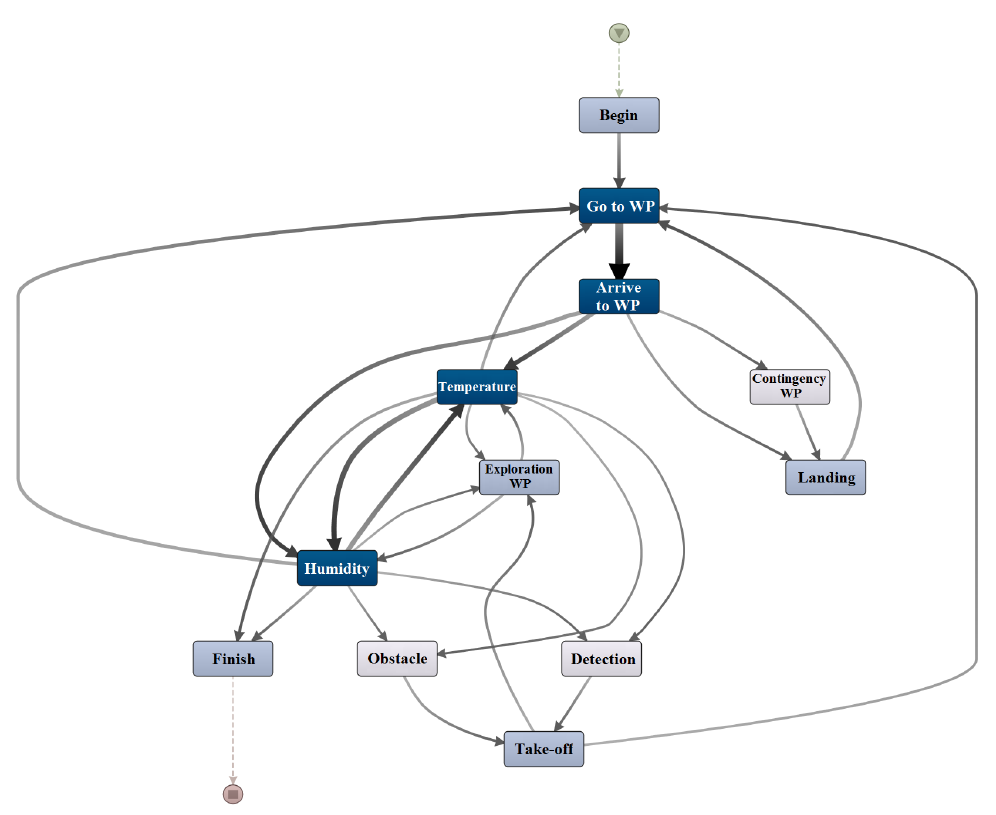
Figure 5. Mission event log.